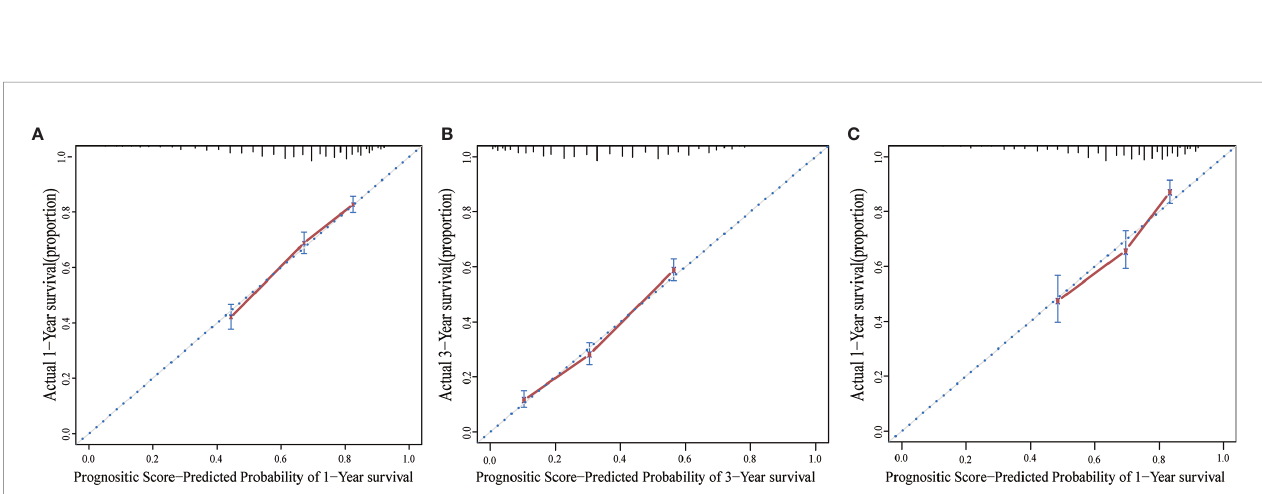
FIGURE 4 | The calibration curve for predicting patient survival at 1 year (A) and 3 years (B) in the training set and at 1 year (C) in the validation